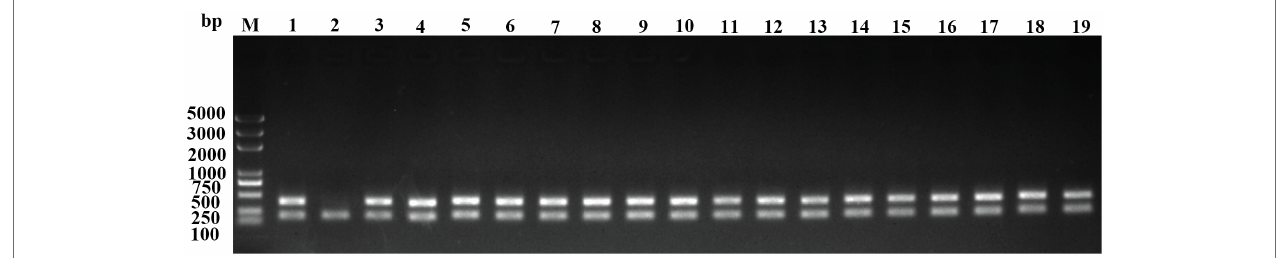
FIGURE 1 | Identification of transposon insertion mutants by colony PCR. The clones grown on plates containing 1 μ g/ml Erm and 20 μ g/ml Gen were resuspended in sterilized water and used as templates to perform PCR using the primers Erm-F/R and 16S rRNA-F/R. Lanes 1 to 18, clone 1 to clone 18; 19, positive control (the genome of RA ATCC11845 ∆ RA0C_1551 :: Erm ); and M, DNA ladder (Biomed, Beijing,